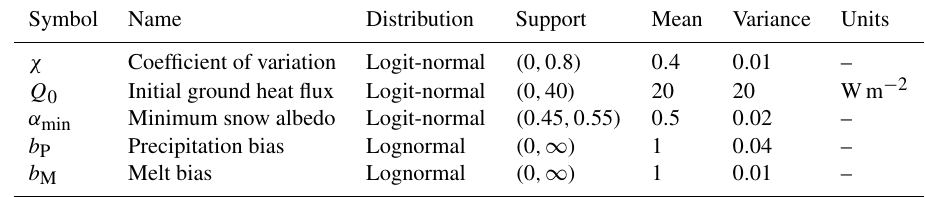
Table 4. Overview of the distributions from which the prior ensemble of perturbation parameters are independently drawn. Symbol Name Distribution Support Mean Variance Units χ Coefficient of variation Logit-normal ( 0 , 0 . 8 ) 0 . 4 0 . 01 – Q 0 Initial ground heat flux Logit-normal ( 0 , 40 ) 20 20 Wm − 2 α min Minimum snow albedo Logit-normal ( 0 . 45 , 0 . 55 ) 0 . 5 0 . 02 – b P Precipitation bias Lognormal ( 0 , ∞ ) 1 0 . 04 – b M Melt bias Lognormal ( 0 , ∞ ) 1 0 . 01